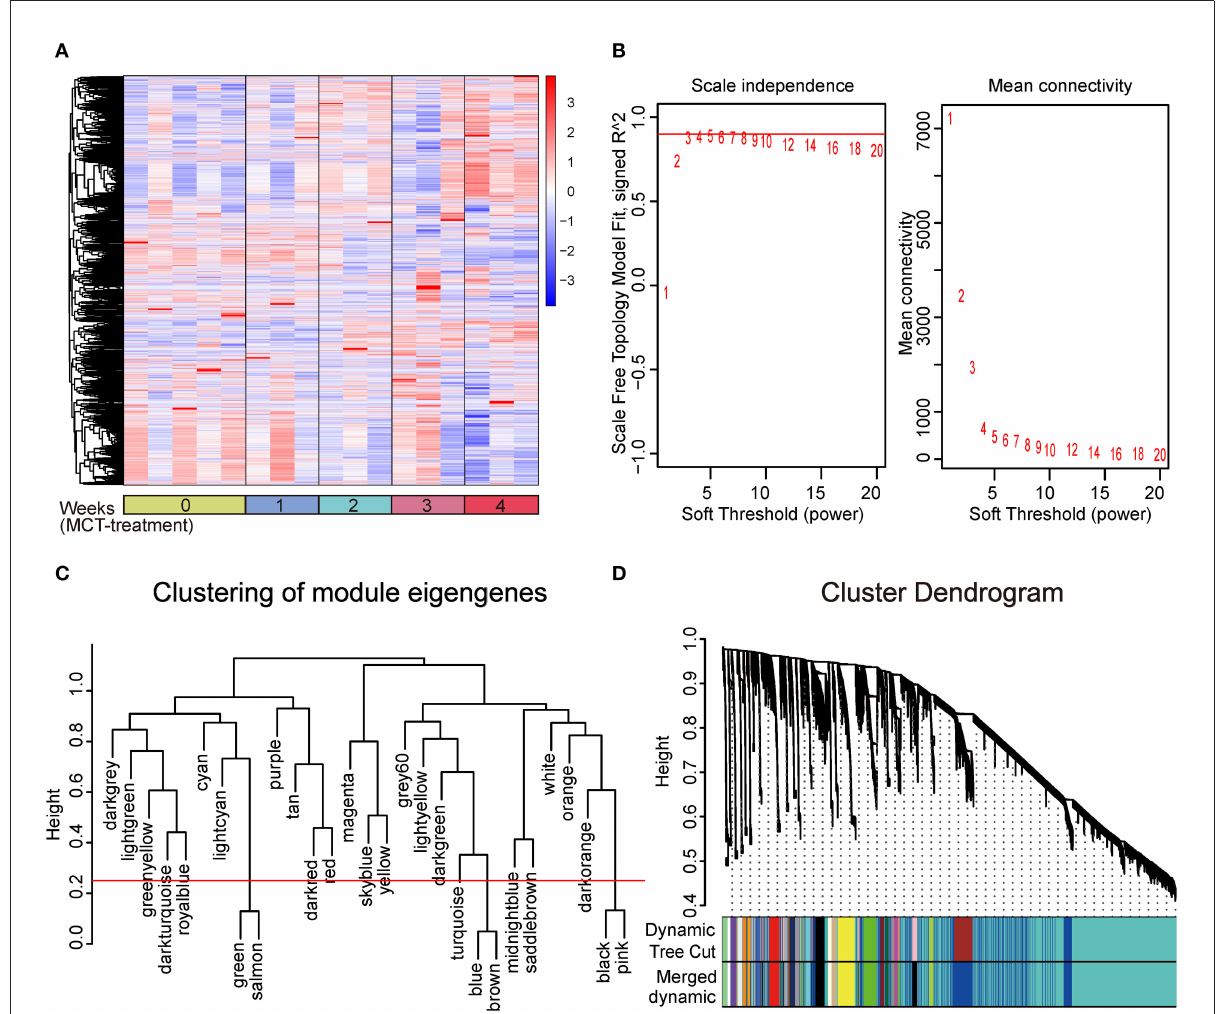
FIGURE1 Construction of weighted gene co-expression network and division of gene co-expression module. (A) Clustering analysis heatmap plot of the expression matrix of 23,200 genes. The rows and columns represent gene expression levels and each sample, respectively. Red and blue represent the elevation and decrease of corresponding gene expression, respectively. (B) Analysis of the scale-free fit index (left) and the mean connectivity (right) for various soft-thresholding powers ( β ), among which four were chosen as the value to construct a scale-free network. (C) Clustering of module eigengenes. The cut height (red line) was 0.25. (D) Clustering dendrogram of all genes, with dissimilarity based on the topological overlap. Each color represents a gene co-expression module. Twenty-six gene co-expression modules were